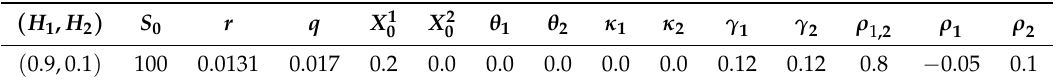
Table 1. Base case parameters.